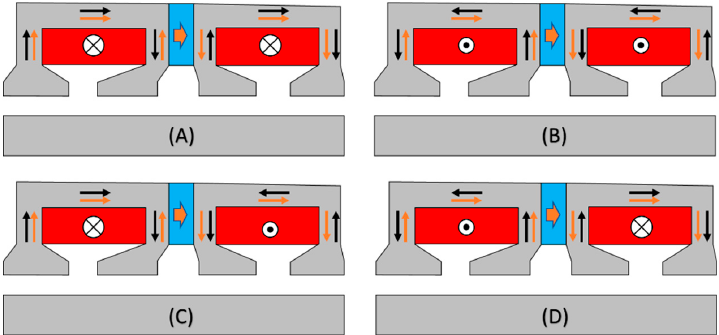
Figure 6. Possible upper coil (UC) supply strategies with concordant ( A , B ) or discordant ( C , D ) current polarities; the orange and black arrows indicate the permanent magnet (PM) and coil flux directions, respectively.